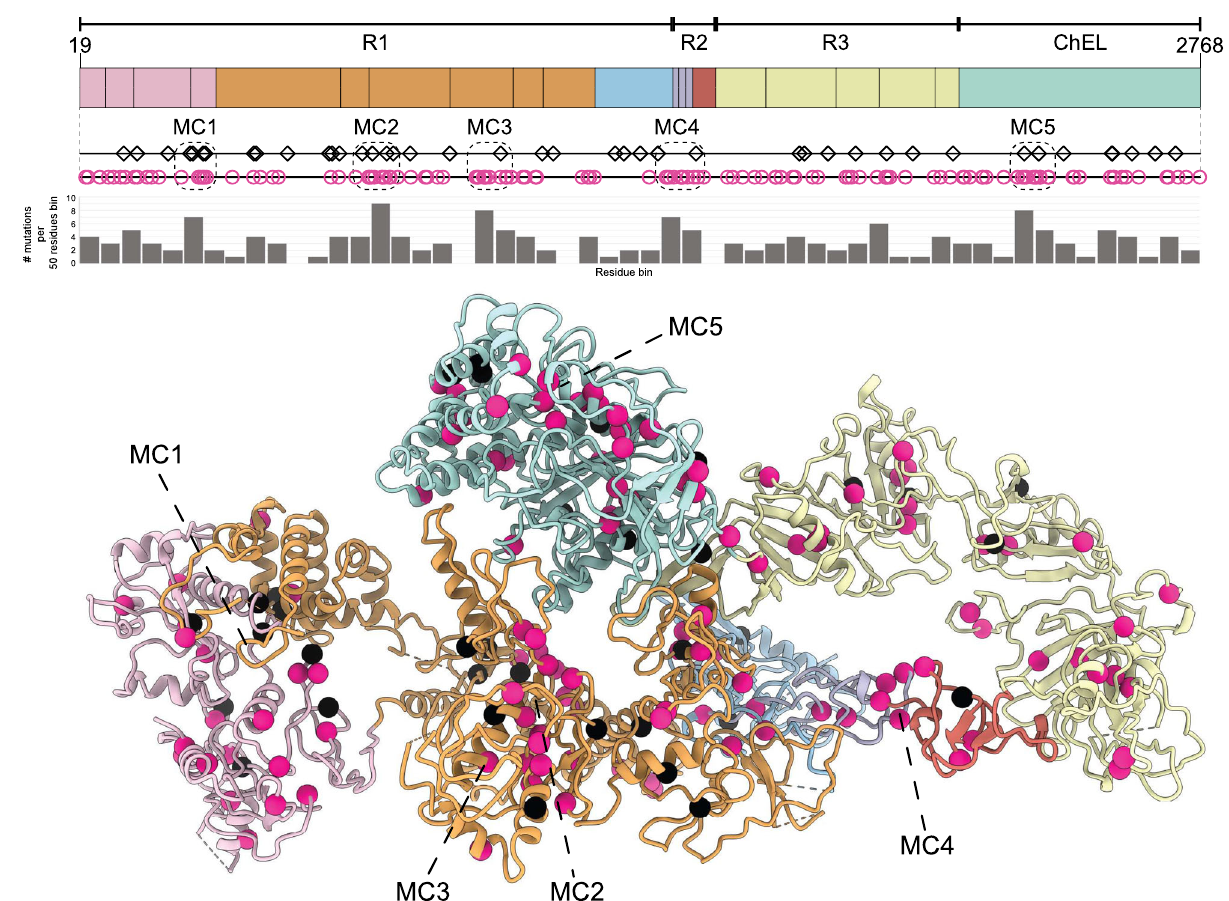
Fig. 7 Location of nonsense and missense mutations in hTG responsible for congenital hypothyroidism. (Top) hTG linear diagram depicting the location of nonsense mutations in black squares and missense mutations in pink circles 34 ; domain color code is the same as Fig. 1. Dashed boxes represent the 5 mutation clusters (MC1 to MC5) with the highest density of mutations. Bar diagram visualizing the number of mutations per 50 residues. (Bottom) Location of the same mutations in the ribbon representation of hTG; nonsense mutations in black spheres and missense mutations in pink